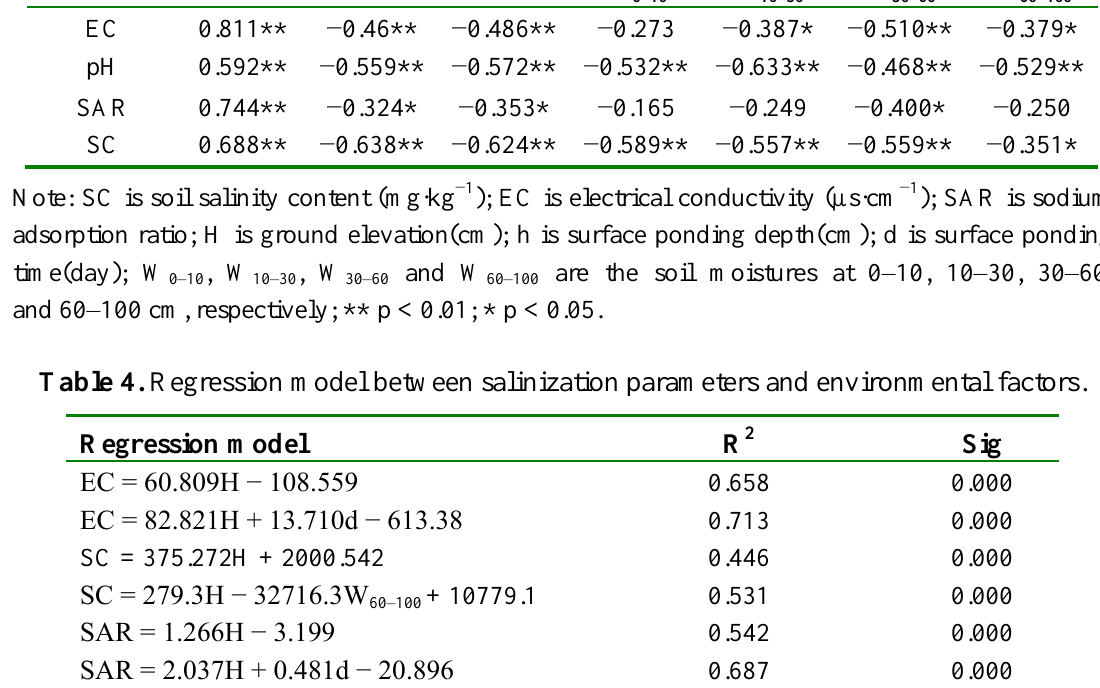
Table 3. Pearson analysis between salinization parameters and environmental factors. Parameter H h d W EC 0.811**